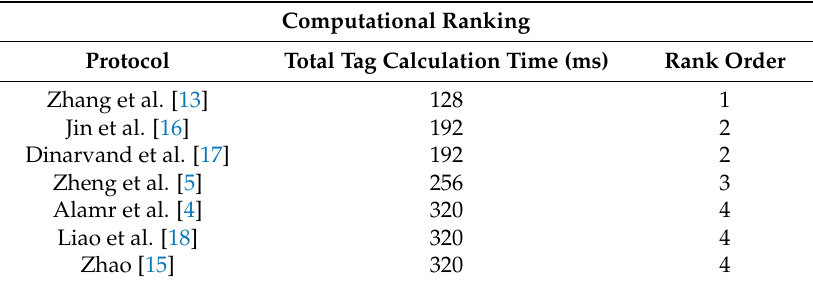
Table 7. Ranking based on reader/server computational cost.